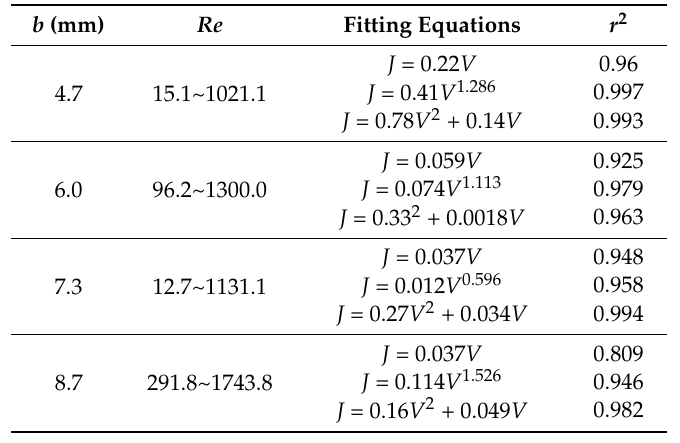
Table 5. Fitting results and goodness of fit for the V – J relationship for flow through single fractures with trapezoidal roughness.